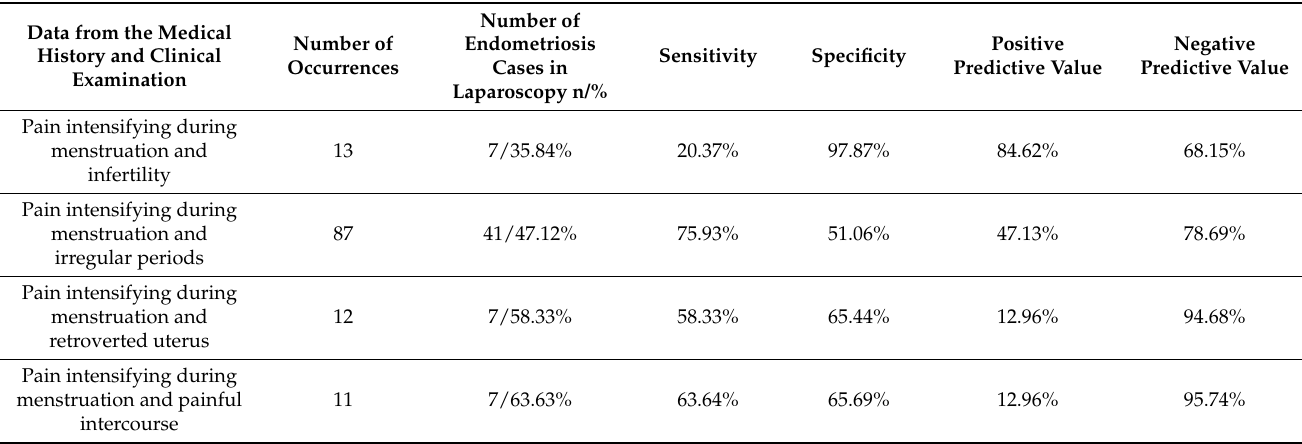
Table 3. Sensitivity, specificity, positive predictive value, and negative predictive value of the two most commonly coexisting symptoms in the diagnosis of